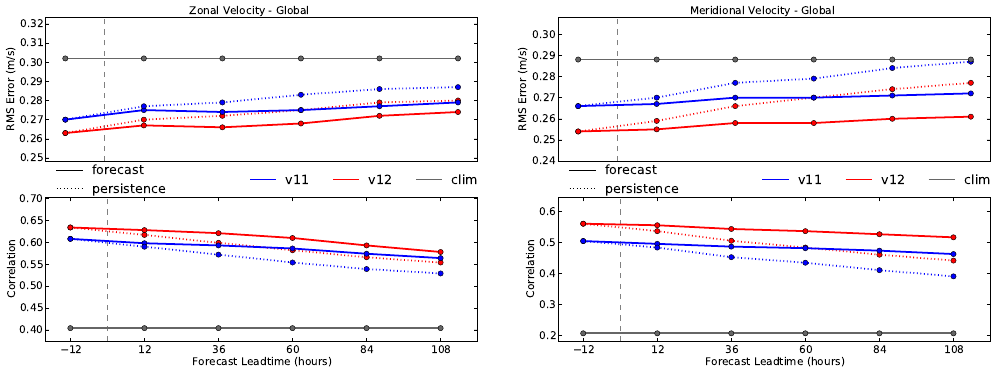
Figure 9. Forecast lead-time plots showing rms errors (upper) and correlation coefficients (lower) against zonal (left) and meridional (right) velocity observations (m s − 1 ) derived from drifter locations. Lines plotted are forecasts (solid lines) and persistence (dotted lines) from the v12 (red) and v11 (blue) trials. Also shown are the corresponding results for climatological velocities (grey solid lines) from the GDP drifter climatology of Lumpkin and Garraffo (2005). The x axis represents forecast lead-time (in hours) ranging from the (daily-mean) analysis fields valid at T − 12h up to the 5-day forecasts at T + 108h. The grey dashed line indicates the location of T + 00h. show that NEMOVAR produces better SST and SSH fields rather than persistence for meridional velocity, particularly in in frontal regions. 1260 the tropics.